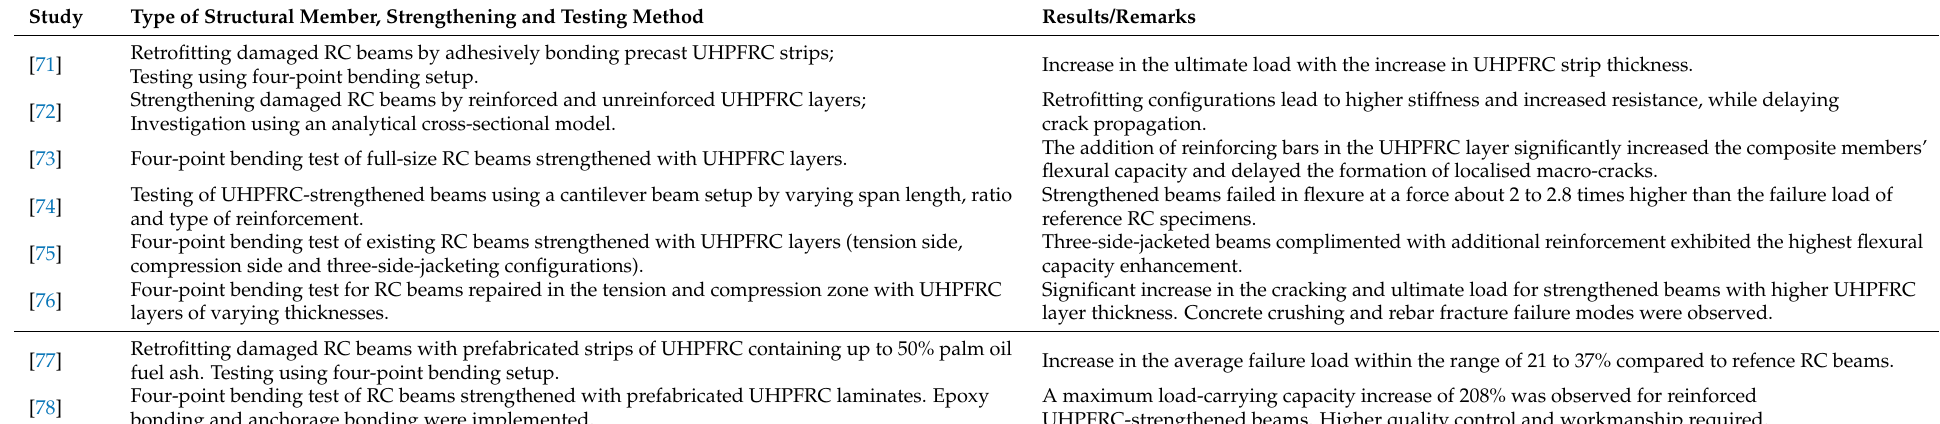
Table 2. Summary of the studies on flexural strengthening using